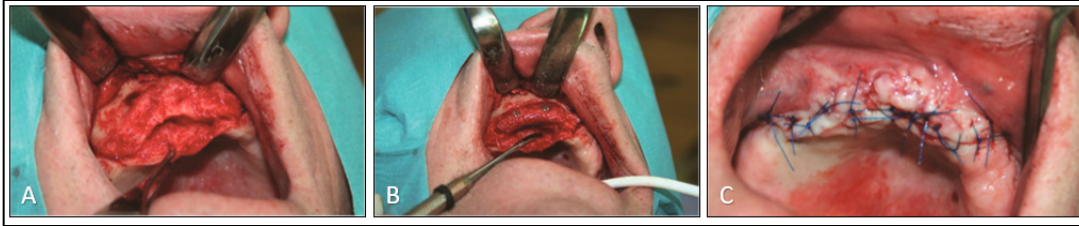
Figure 4. Surgical phase: ( A ) skeletonization of the defect area, ( B ) graft positioning and screws fixation and ( C ) soft tissue sutures.